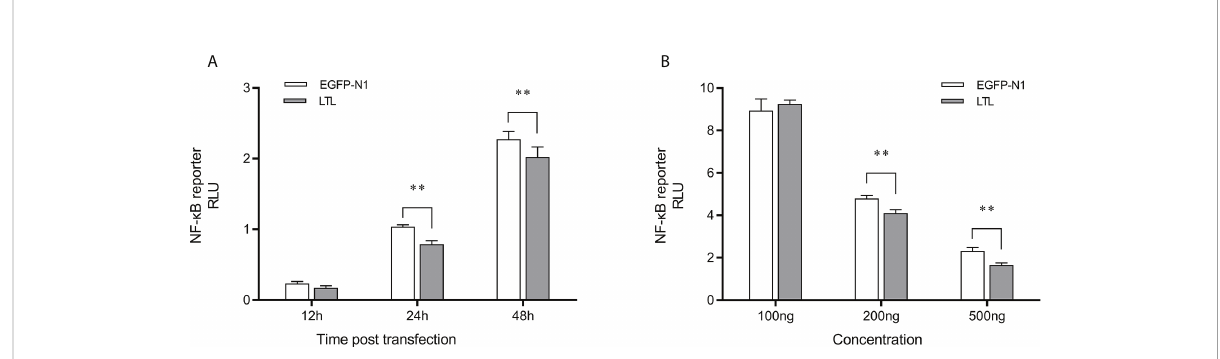
FIGURE 9 Effects of overexpressed OppLTL on the activation of the NF- k B signal pathway. (A) The 500-ng OppLTL-EGFP with 100 ng NF- k B luciferase reporter plasmids was co-transfected into HEK293T cells. Luciferase detection was applied at 12, 24, and 48 h after transfection, respectively. (B) Furthermore, 100, 200, and 500 of ng OppLTL-EGFP were co-transfected with 100 ng NF- k B luciferase reporter plasmids into HEK293T cells, respectively. Luciferase detection was applied at 48 h after transfection. Data was shown as mean ± SD ( n = 6). Bars with an asterisk symbol indicate signi fi cant differences (** P <